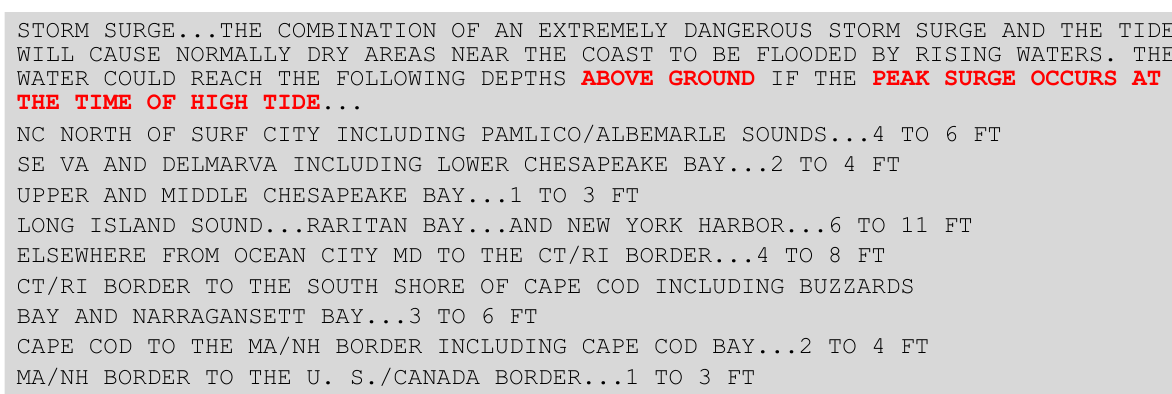
Figure 4. The National Hurricane Center’s (NHC) Public Advisory 26A, valid at 8:00 PM EDT (00:00 UTC) on Sunday, 28 October 2012; one day before Hurricane Sandy made landfall. Note that the inundation depths are given in feet above ground level, with